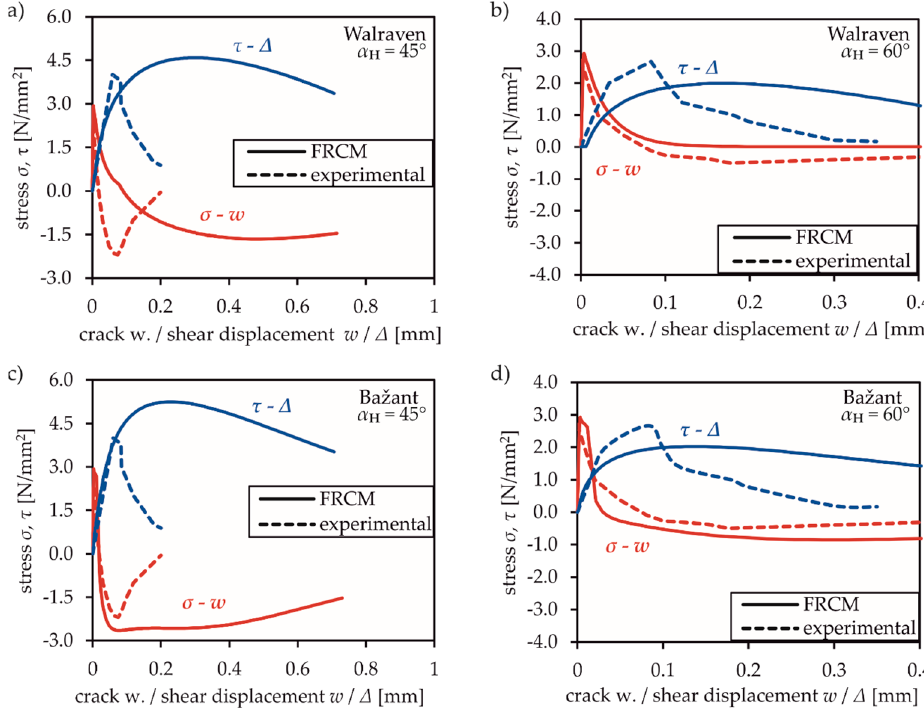
Figure 11. Comparison of numerical stress-displacement curves (FRCM) with experimental results, FRCM with Walraven for ( a ) α H = 45° and ( b ) α H = 60°, FRCM with Bažant for ( c ) α H = 45° and ( d ) α H = 60°.